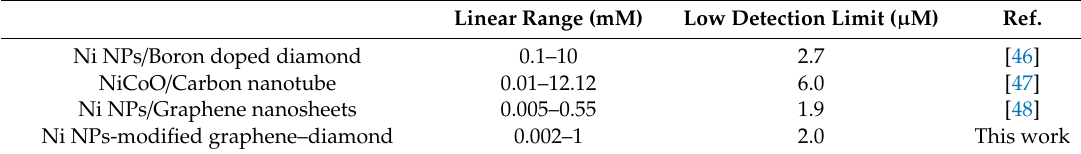
Table 2. Glucose sensing performance using Ni NPs-modified carbon-based electrodes.